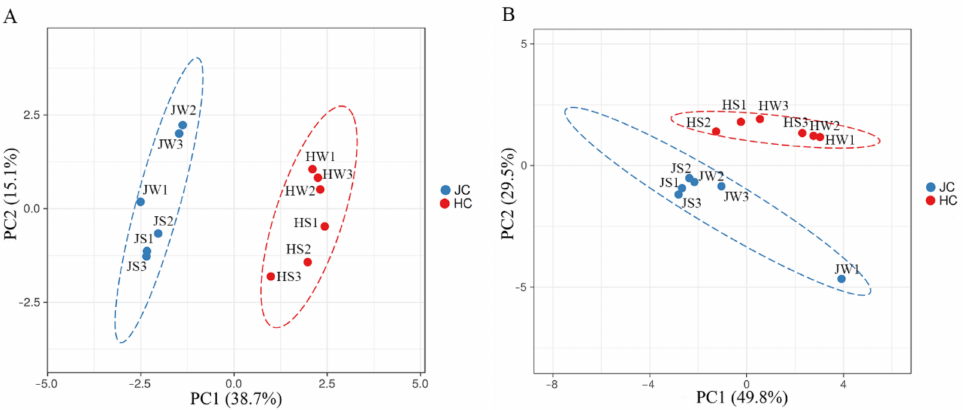
Figure 3. Comparison of bacterial microbiota on Jamaican and house crickets by principal coor- dinate analysis (PCoA). Plots were calculated using weighted ( A ) and unweighted ( B ) UniFrac distances. JS—Jamaican cricket surface, JW—Jamaican cricket whole-body, HS—house cricket sur- face, HW—house cricket whole-body. Each dot represents a distinct sample.